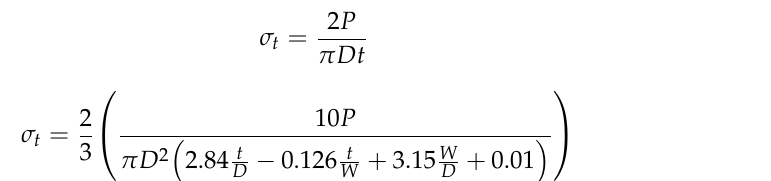
Figure 4. Tablet characterization summary from USP1062 guide.